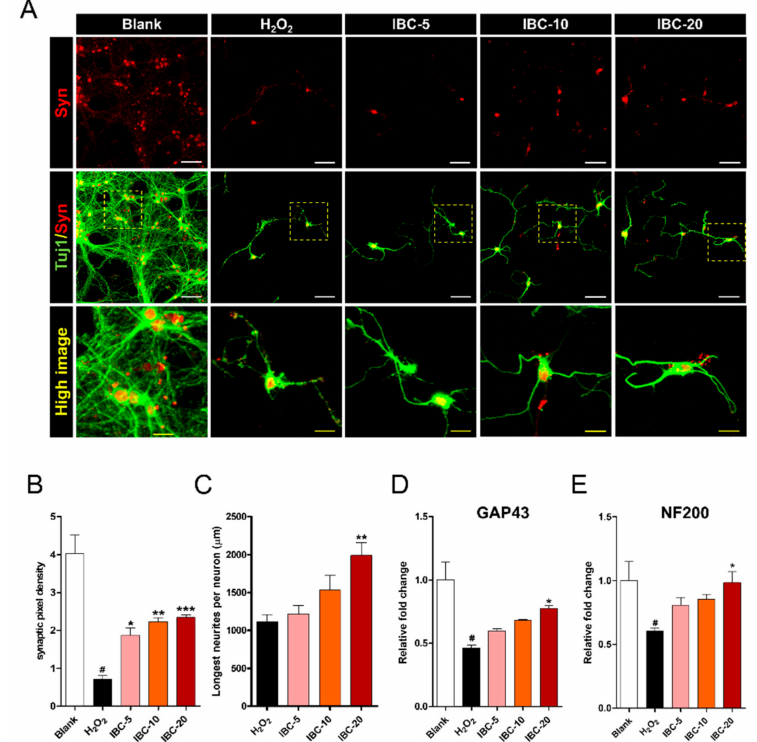
Figure 9. Effect of IBC extract on synapse formation and stabilization following H 2 O 2 -induced oxidative stress injury of rat primary cortical neurons. ( A ) Representative images of low and high anti-synaptophysin (Syn) staining at 7 DIV (day in vitro). White scale bar = 50 µ m, Yellow scale bar = 15 µ m. ( B , C ) Quantification of synaptic densities ( B ) and the length of the longest neurite ( C ) determined by Tuj1 immunoreactivity in neurons at 7 DIV (n = 7). ( D , E ) Gene expression associated with neuronal growth in cortical neurons, assessed using qRT-PCR (n = 6); ( D ) GAP43 and ( E ) NF200 . Data are expressed as the means ± SEM. Significant differences indicated as # p < 0.001 compared vs. the blank group, * p < 0.05, ** p < 0.01 and *** p < 0.001 vs. the H 2 O 2 group were analyzed via one-way ANOVA with Tukey’s post hoc